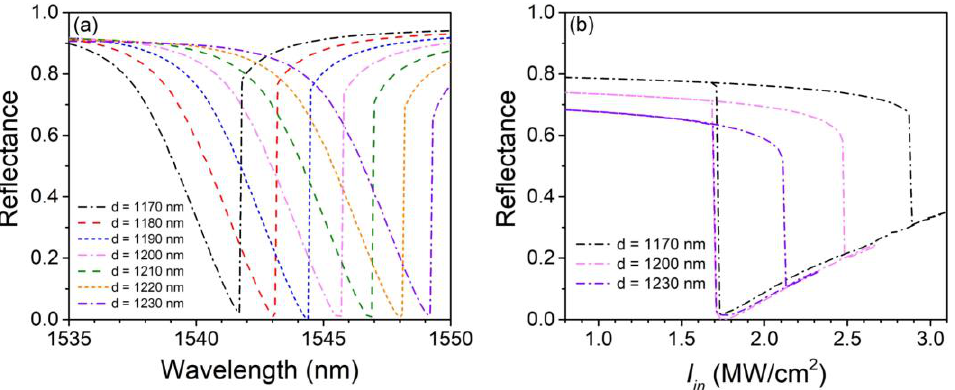
Figure 4. ( a ) Nonlinear reflectance spectrums with different silica layer thicknesses d . ( b ) Hysteresis loops with d = 1170, 1200, and 1230 nm, respectively.